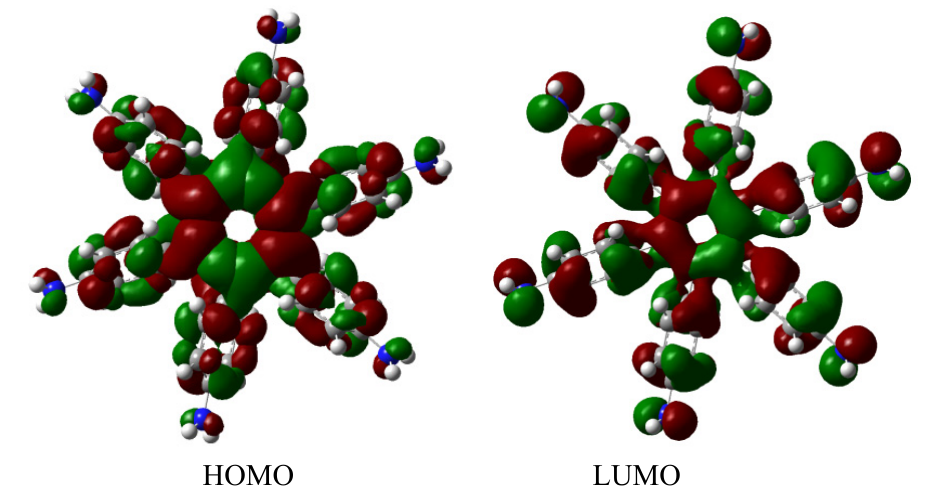
Figure 11. Frontier molecular orbitals for HAB5 .